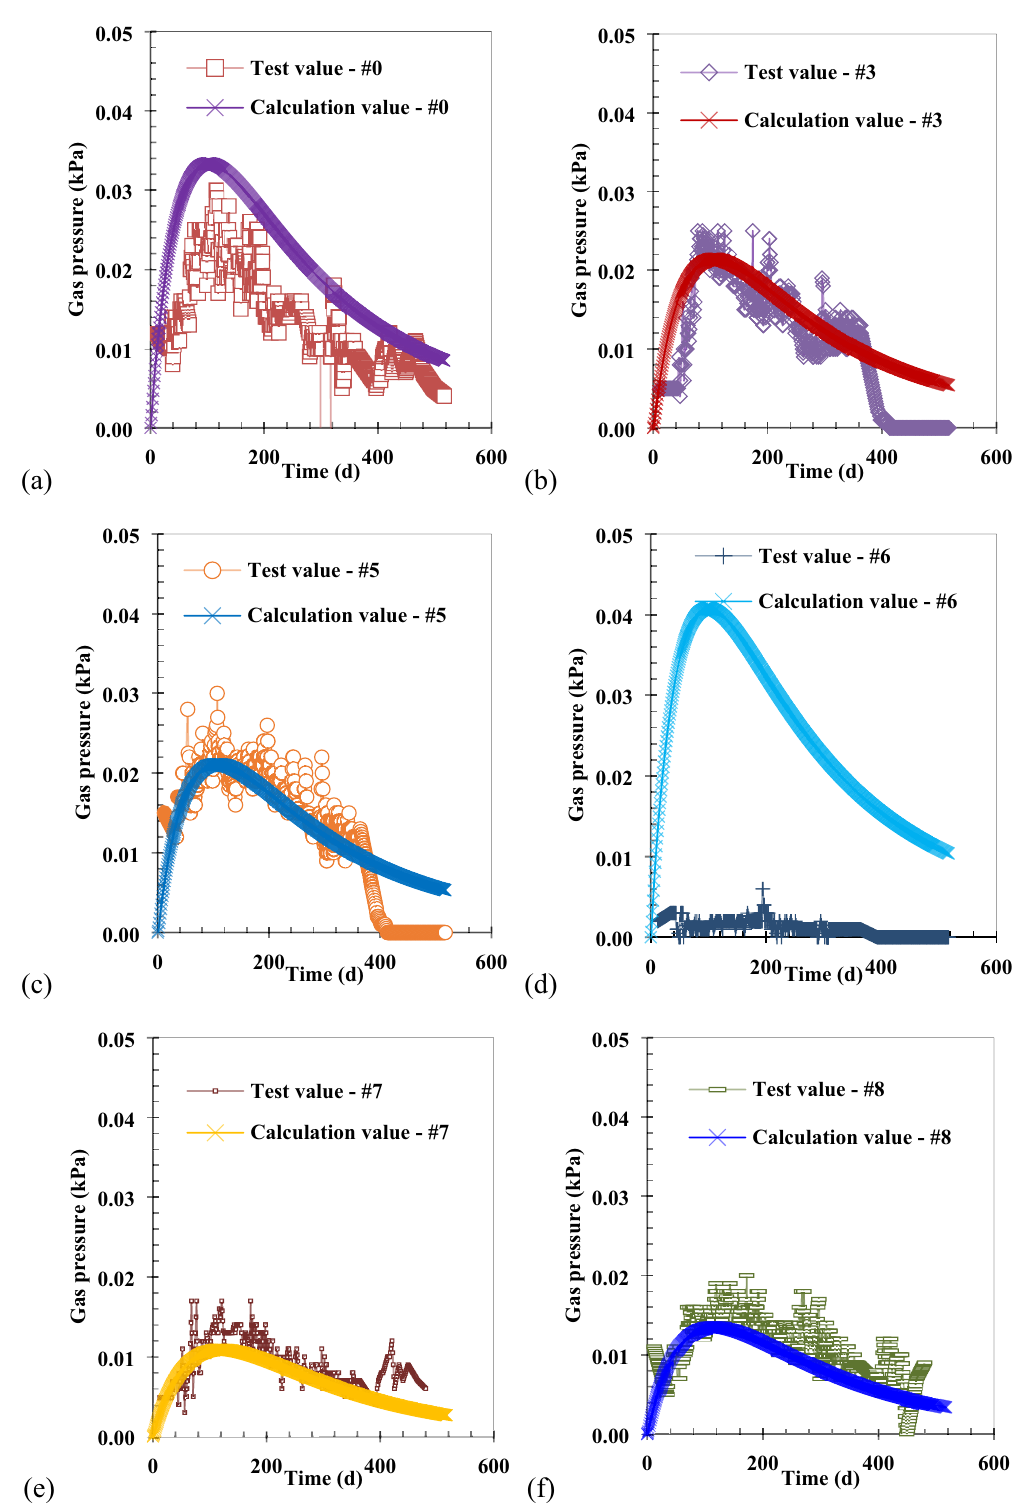
Figure 5. Comparison of calculation and test values of gas pressure with time at the bottom of different wells: ( a ) #0 well (Depth: 8.74 m); ( b ) #3 well (Depth: 3.64 m); ( c ) #5 well (Depth: 3.58 m); ( d ) #6 well (Depth: 6.56 m); ( e ) #7 well (Depth: 1.34 m); ( f ) #8 well (Depth: 2.05